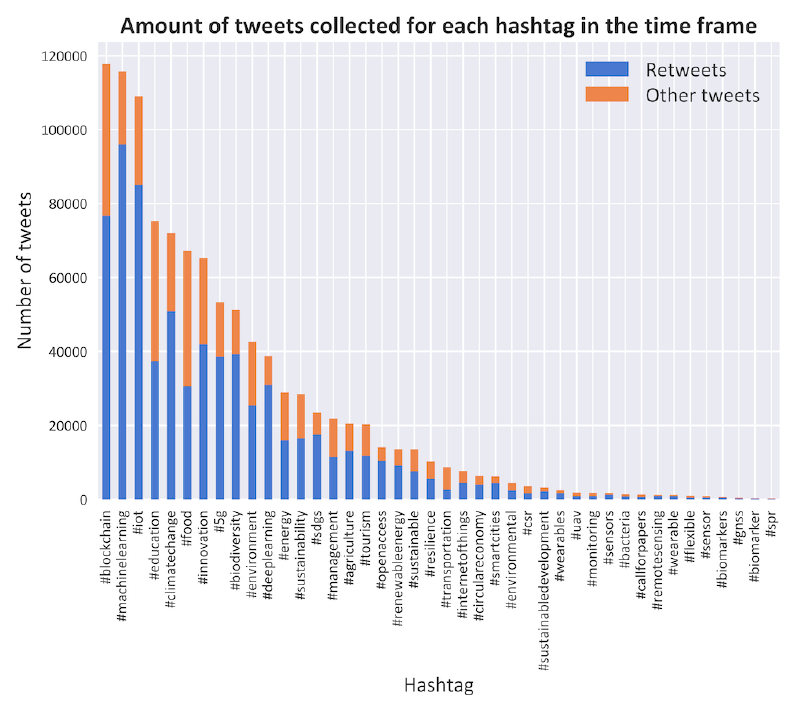
Figure 3. Amount of retweets and other tweets collected for the selected hashtags that contain more than 100